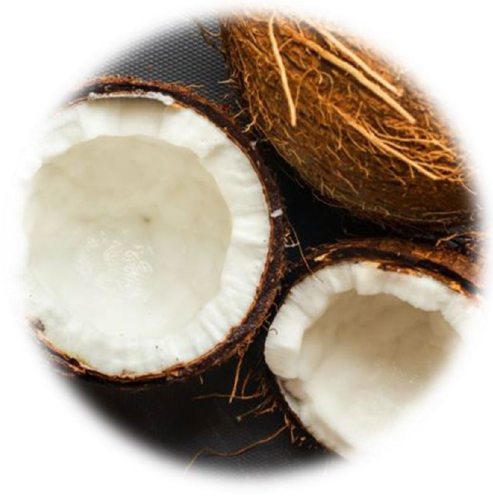
Fig. 8 Coccinia Indica Mucilage as coagulant Fig. 9 Seed protein of Cocos nucifera as